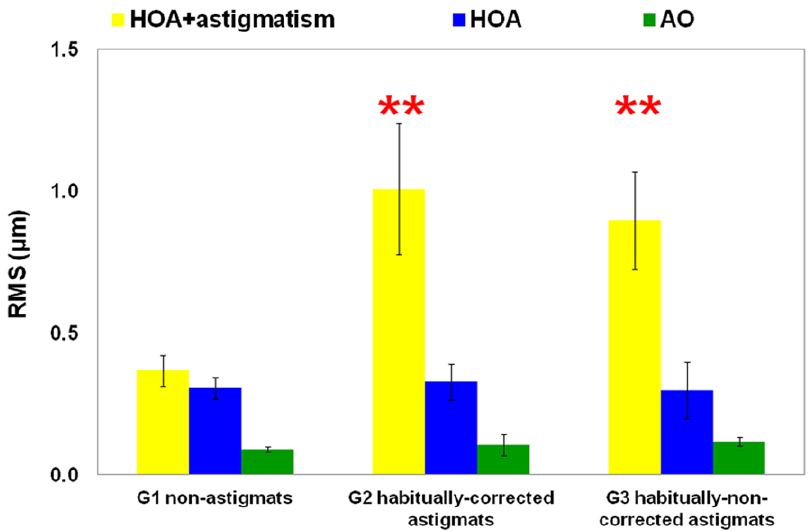
Figure 2. RMS wavefront error. RMS wavefront error for natural aberrations for HOAs and astigmatism (yellow bars), HOAs (blue bars), and, residual aberrations after AO correction (green bars), averaged across subjects, groups and measurement sessions. Error bars indicate inter-subject variability. ** indicates a significantly larger RMS (p , 0.01) for HOA + astigmatism for G2 and G3 than for G1.